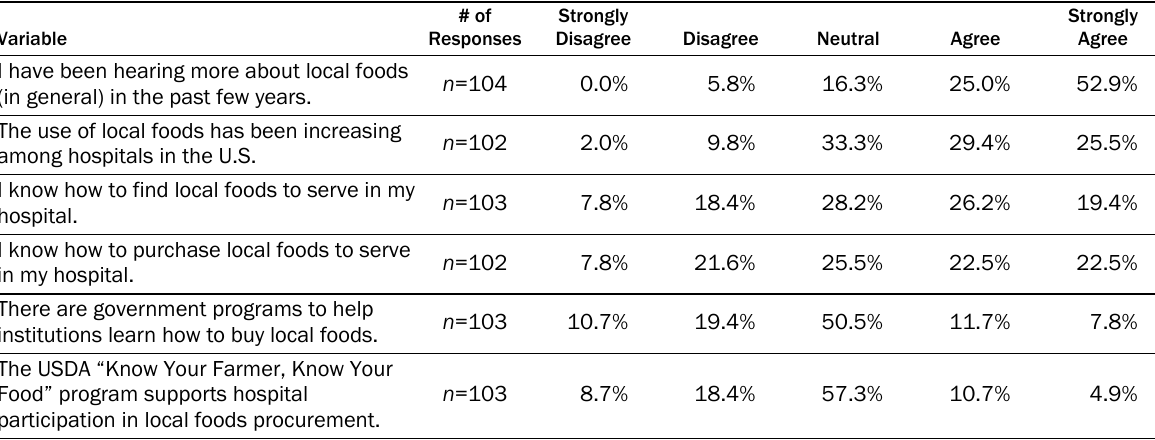
Table 2. Level of Knowledge of Local